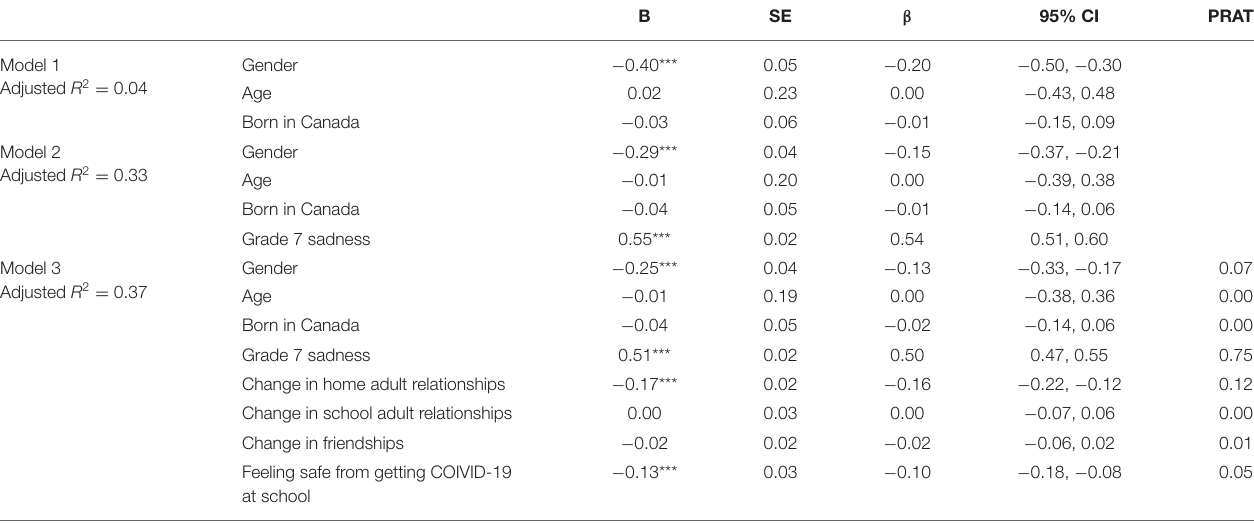
B SE β 95% CI PRATT